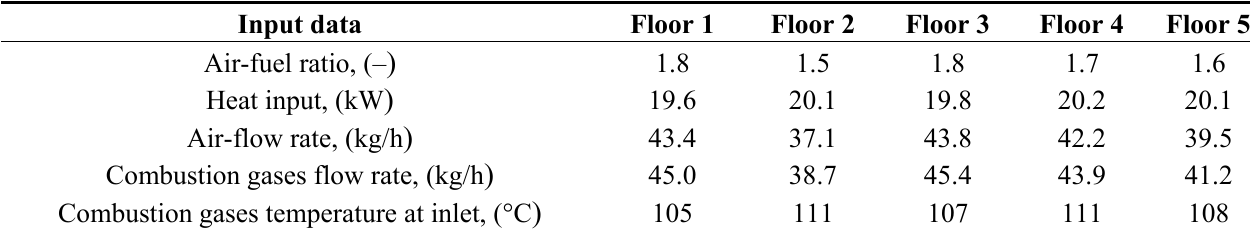
Table 2. Input data for verification